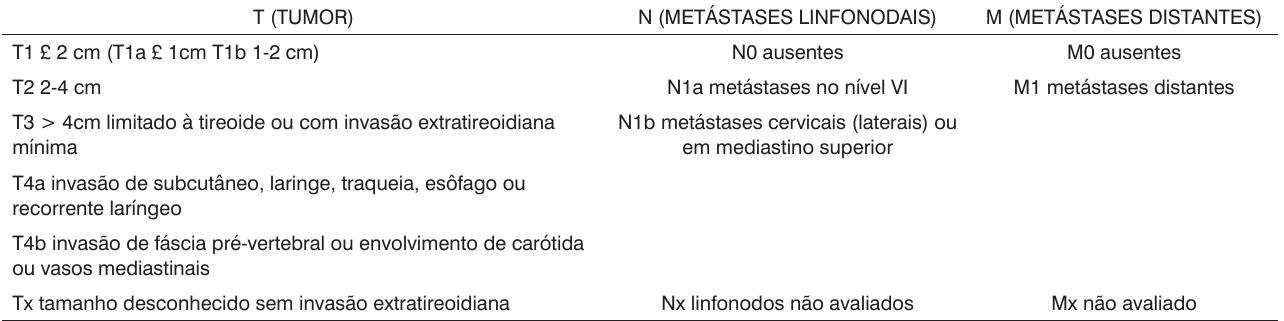
Tabela 1. Classificação TNM para câncer de tireoide T (TUMOR)